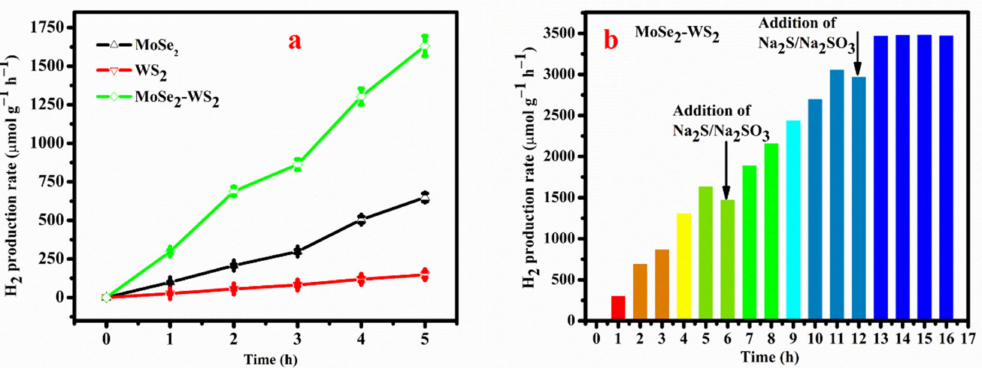
Figure 7. ( a ) H 2 generation rate of MoSe 2 , WS 2 , and MoSe 2 -WS 2 catalysts and ( b ) continuous cycling stability of MoSe 2 -WS 2 catalyst under visible light irradiation.